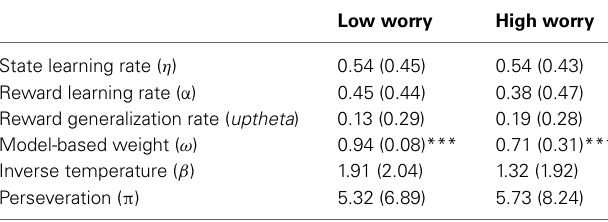
Table 2 | Average Best-Fitting Parameter Estimates for the RL